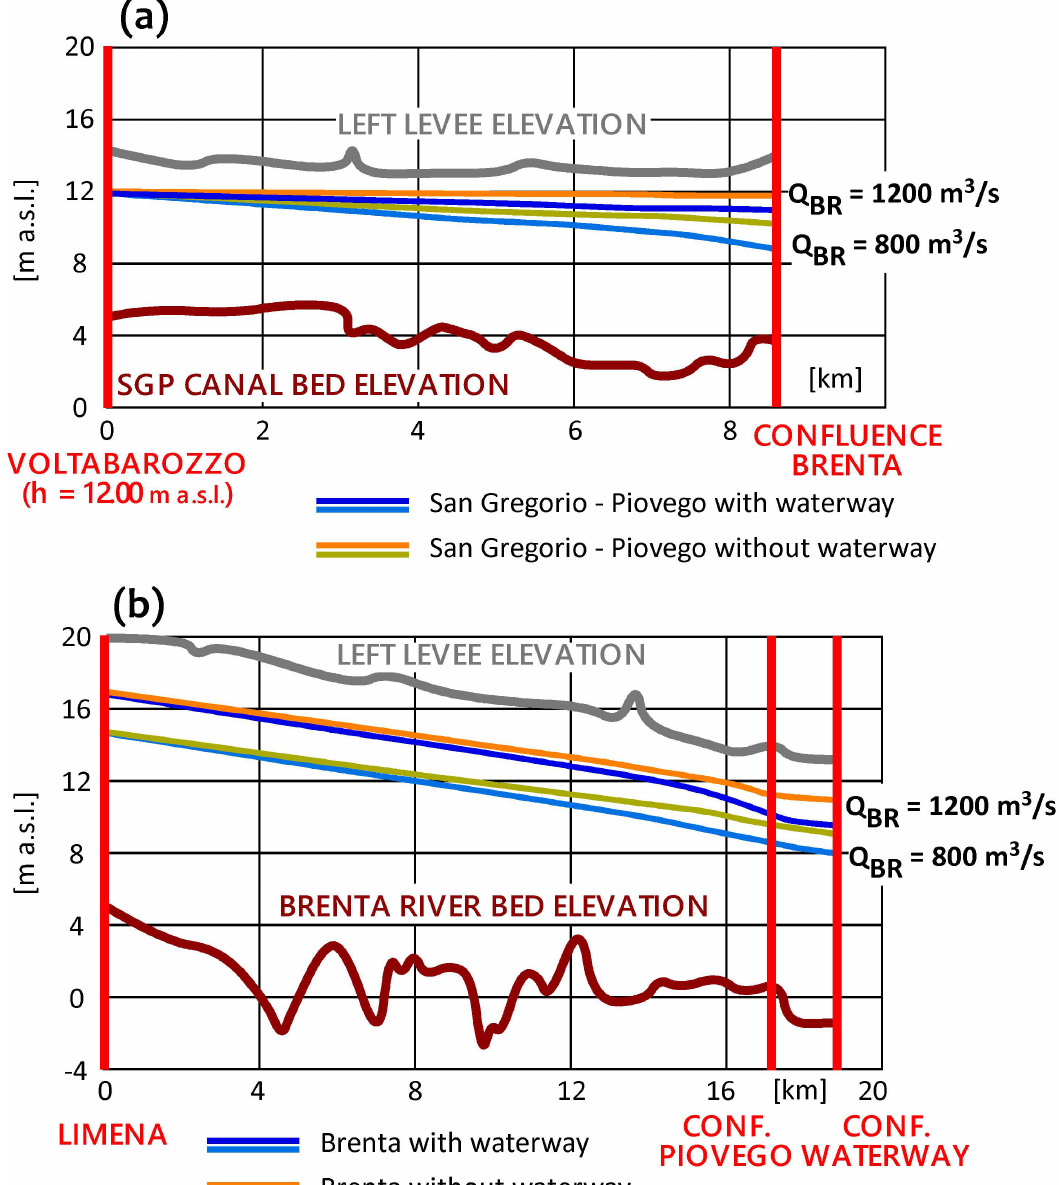
Figure 5. The role of the waterway in reducing the water levels in the SGP Canal and in the Brenta River, under steady flow conditions. Examples with water level upstream of the VCS of 12 m a.s.l. and flow rates in the Brenta River, Q BR , of 800 and 1200 m 3 / s. Brown line is the bed elevation; grey lines are the elevation of the lower levee. ( a ) Water levels along the SGP Canal from the VCS to the confluence of Piovego–Brenta; and ( b ) water levels in the Brenta River from the Limena to the